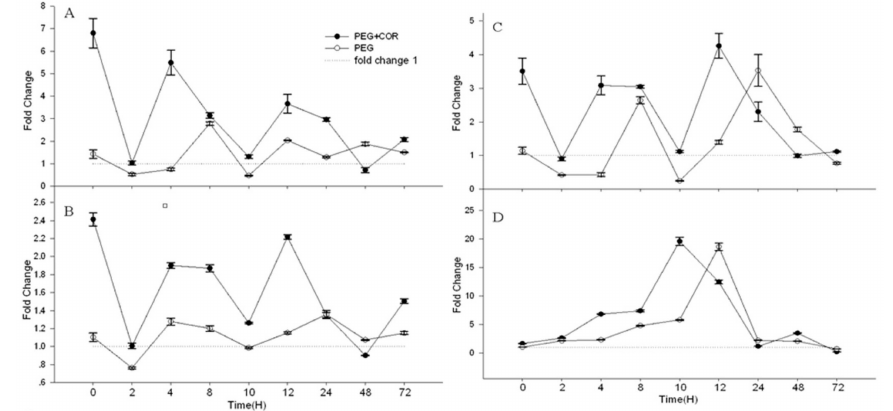
Figure 7. The changes of four genes expression in relation with the time. The expression data are presented for ( A ): Os01g0298400 ( MYB9 ), ( B ): Os08g0520500 ( ARF2 ), ( C ): Os04g0578000 ( ACS ) and ( D ): Os04g0447700 ( DCHS ). PEG, Water deficit treatment induced by PEG for 10 h without COR pretreatment; COR + PEG, Pretreatment with 0.1 µ M COR for 12 h before PEG treatment. The sample was collected in 2 h, 4 h, 8 h, 10 h, 12 h, 24 h, 48 h, and 72